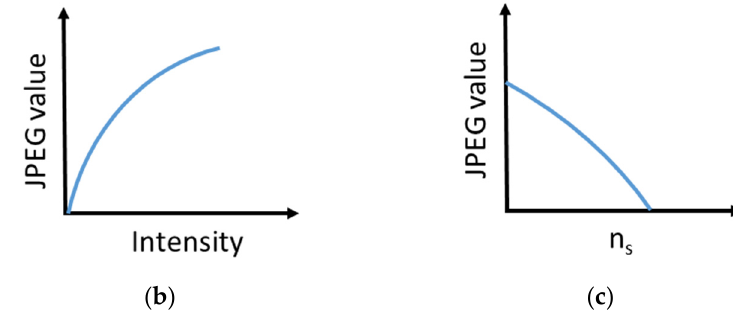
Figure 6. ( a ) Schematic illustrations of ( a ) the dependence of the diffracted intensity on the liquid sample refractive index (n s ), ( b ) the dependence of the JPEG response on the light intensity (gamma correction), and ( c ) the resulting JPEG value dependence on the sample refractive index.